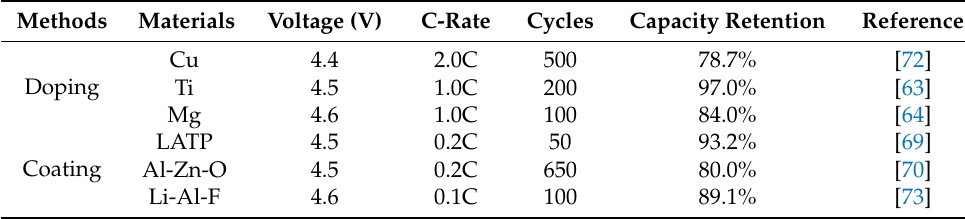
Table 1. Capacity performance of modified high-voltage LCO